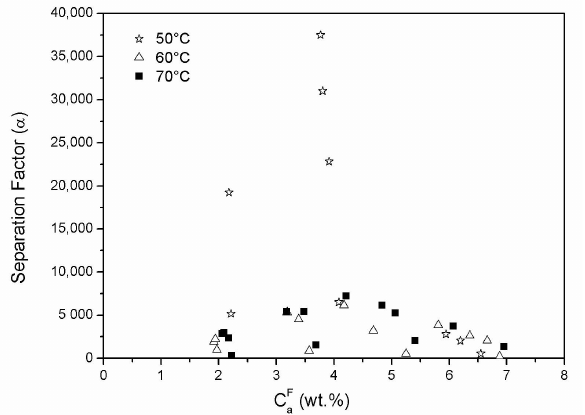
Figure 4. Separation factor for different temperatures and concentration values.